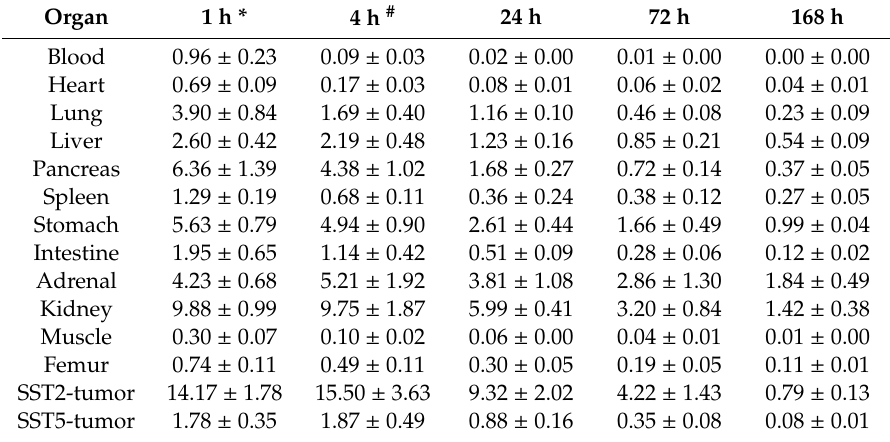
Table 5. Results of the pharmacokinetics studies of [ 177 Lu]Lu-DOTA-ST8950 (100 pmol) on dual SST2- and SST5-expressing xenografts. The results are expressed as mean of the % injected activity per gram of tissue (%IA / g) ± standard deviation (SD).